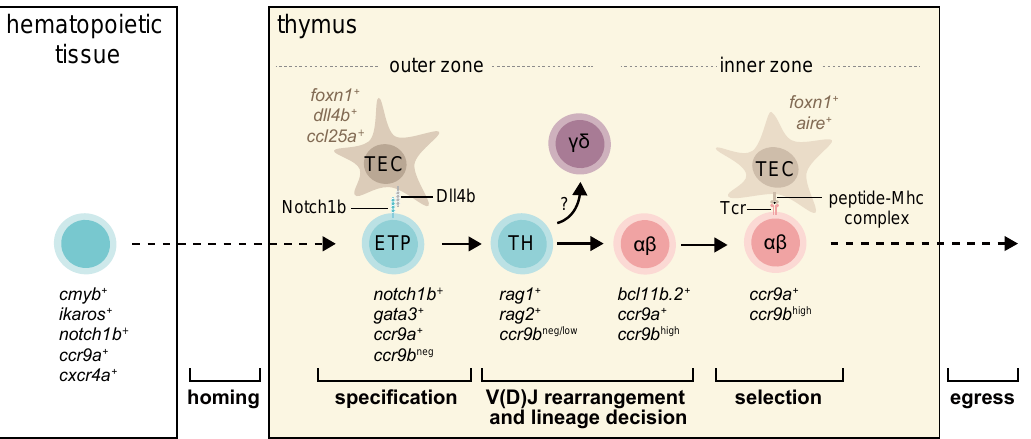
Figure 2. The current model of T-cell development in teleosts. A schematic illustration of stages of T-cell development in zebrafish and medaka, highlighting the expression of marker genes at each developmental stage based on previous studies [31,32,43]. Dashed arrows mean migration into and out of the thymus. Arrows mean development into a next stage. Abbreviations: ETP, early T-cell progenitor; TEC, thymic epithelial cells; TH, thymocytes.